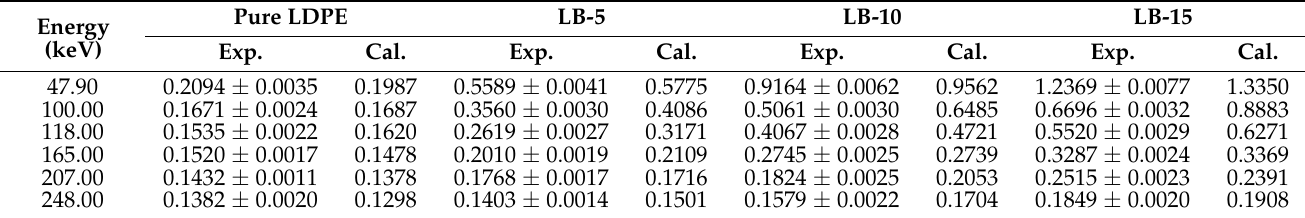
Table 7. The experimental and calculated values of the mass attenuation coefficient.